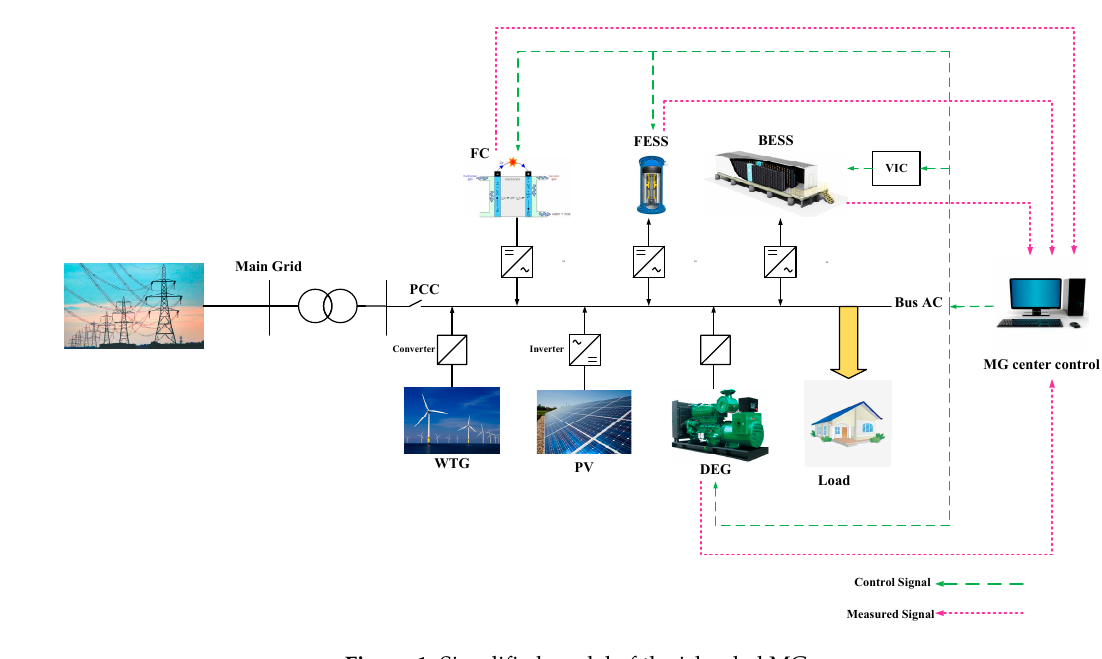
Figure 1. Simplified model of the islanded MG.